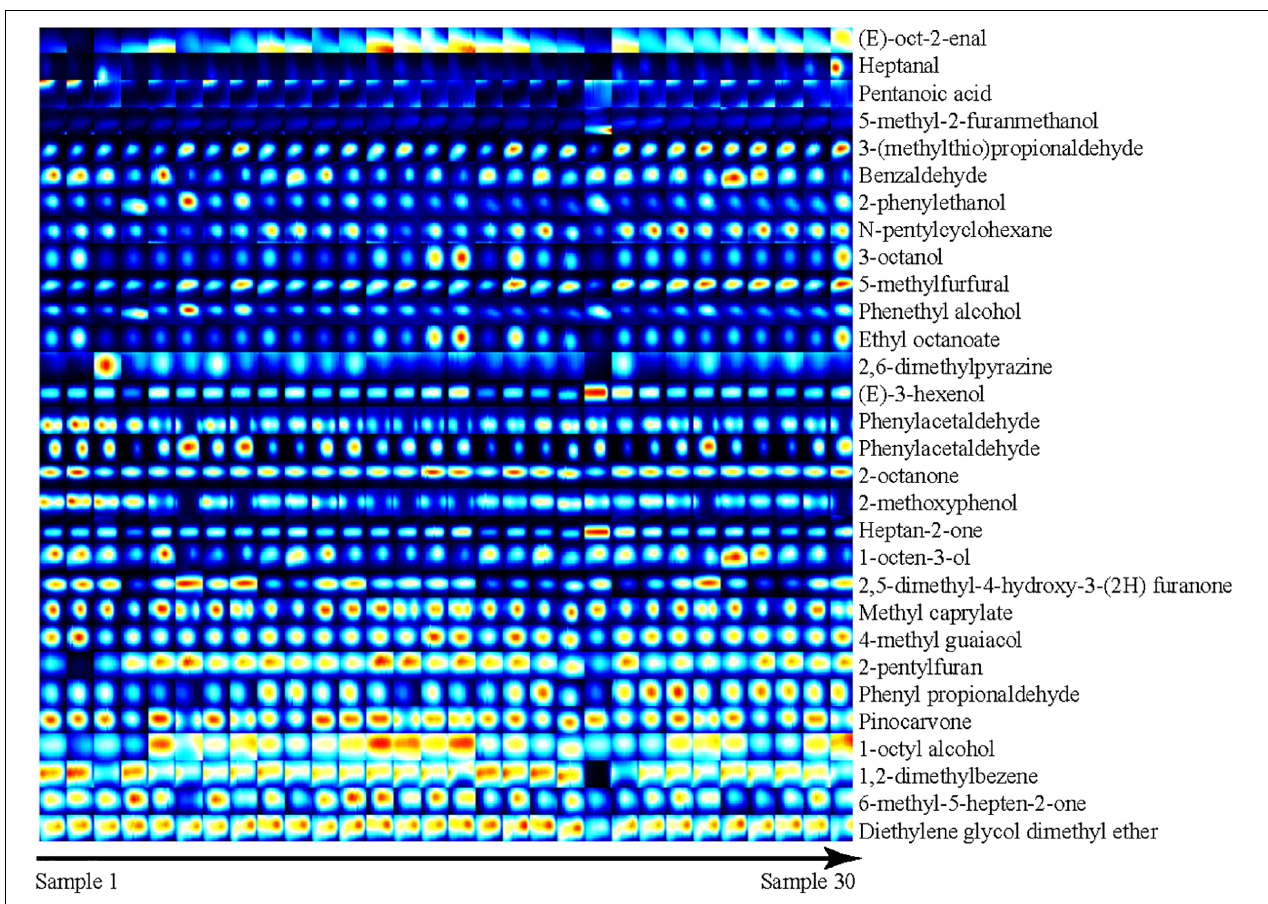
FIGURE 4 | Fingerprint of volatile compounds in Dongxiang tribute